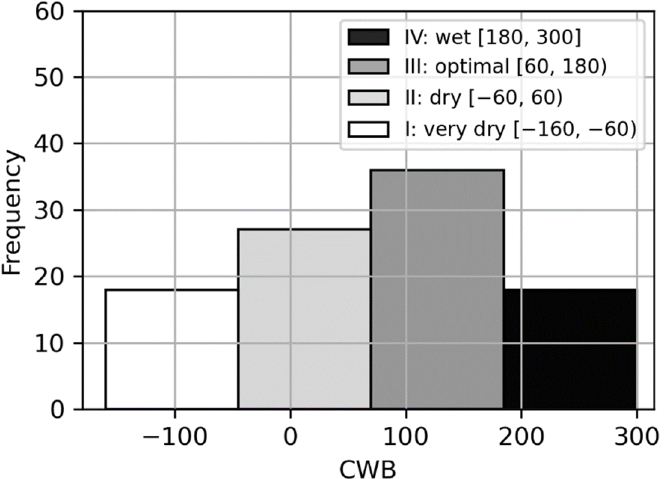
Figure 1. Histogram and frequency tabulation of the total Climatic Water Balance (CWB) (mm) for the potato growing season (May–August) in the years 2005–2015 and the split into four categories: very dry, dry, optimal, and